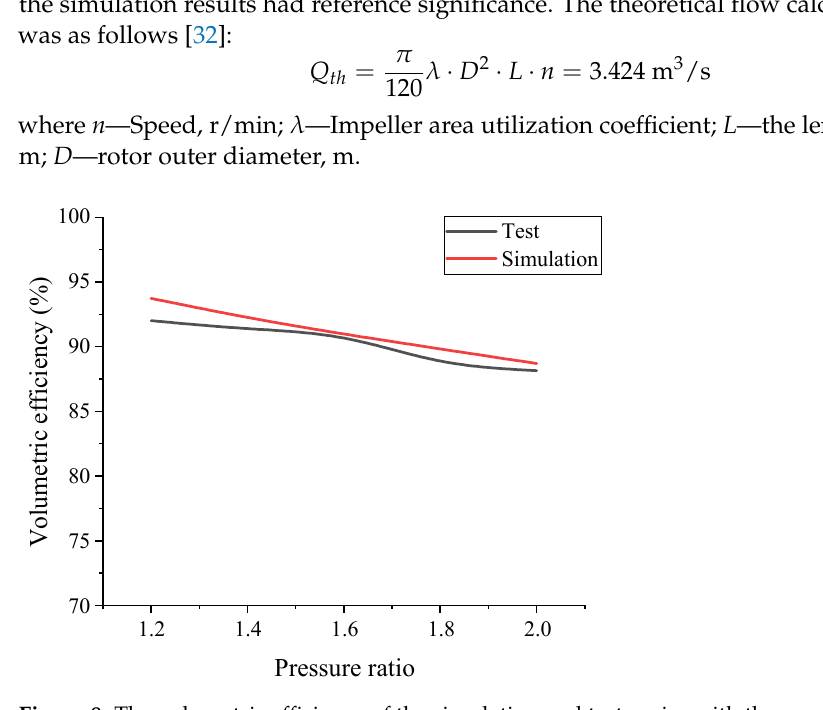
Figure 8. The volumetric efficiency of the simulation and test varies with the pressure ratio.